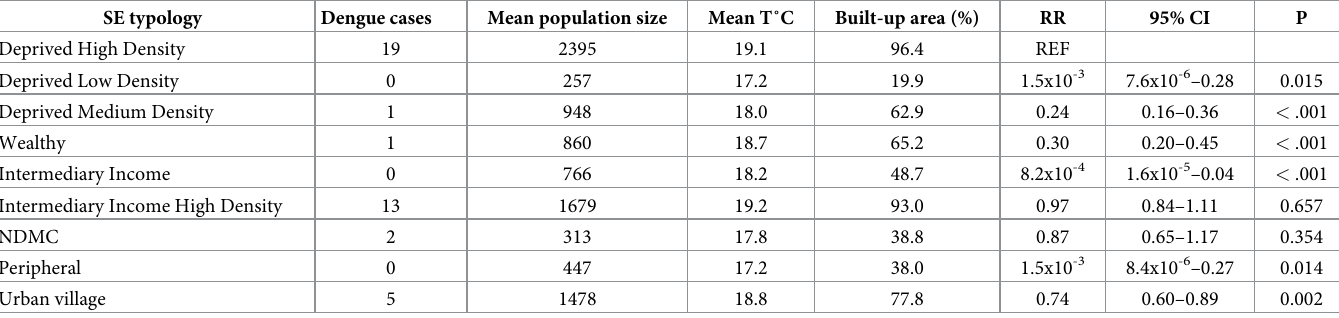
Table 3. Risk of winter dengue cases in 250 m x 250 m units associated with Socio-economic typology. SE